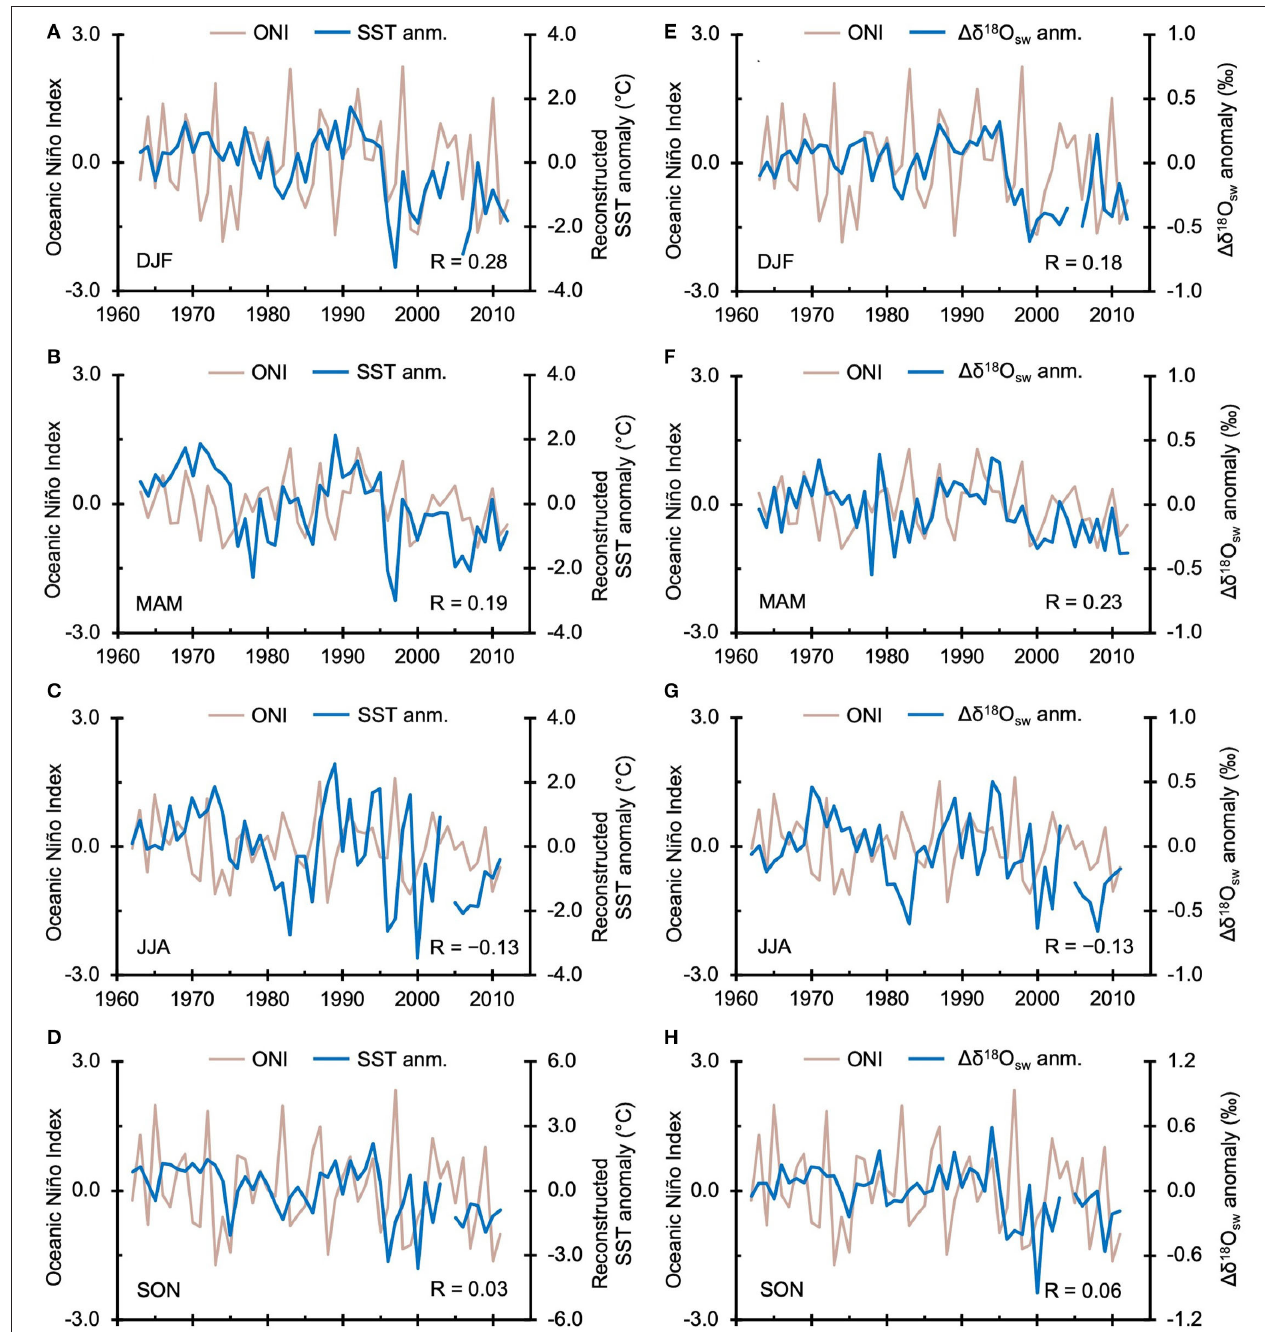
FIGURE 7 | Seasonal Oceanic Niño Index (ONI) compared seasonal SST anomaly (left panels) and seasonal 1 δ 18 O sw anomaly (right panels): (A,E) December–January–February (DJF), (B,F) March–April–May (MAM), (C,G) June–July–August (JJA), and (D,H) September–October–November